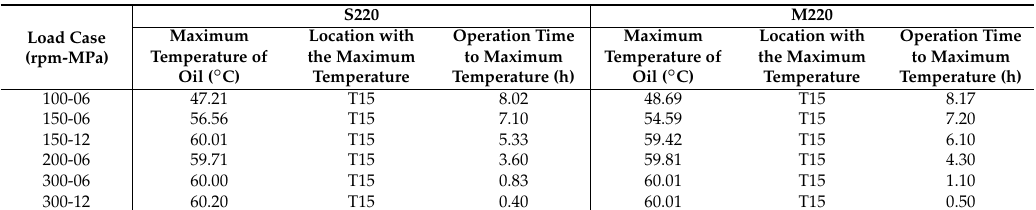
Table 5. Operation time and maximum temperature under different load